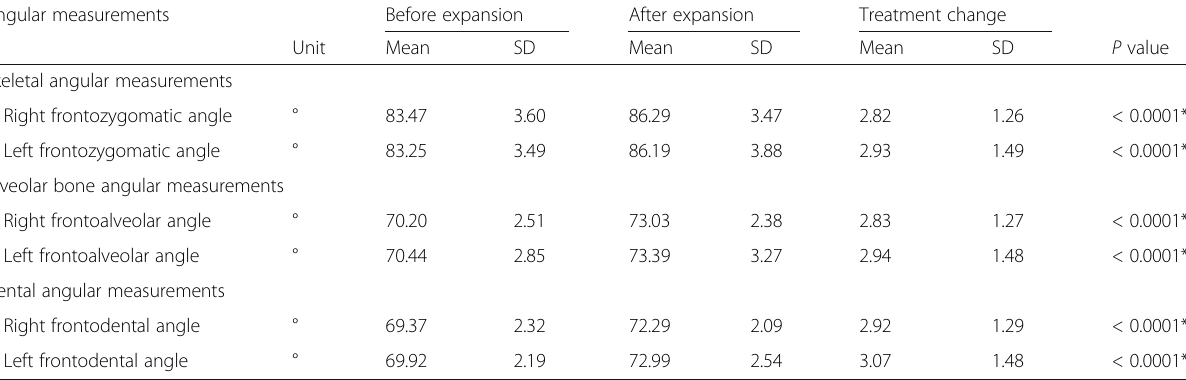
Table 2 Skeletal, alveolar bone, and dental angular measurements Angular measurements Before expansion After expansion Treatment change Skeletal angular measurements